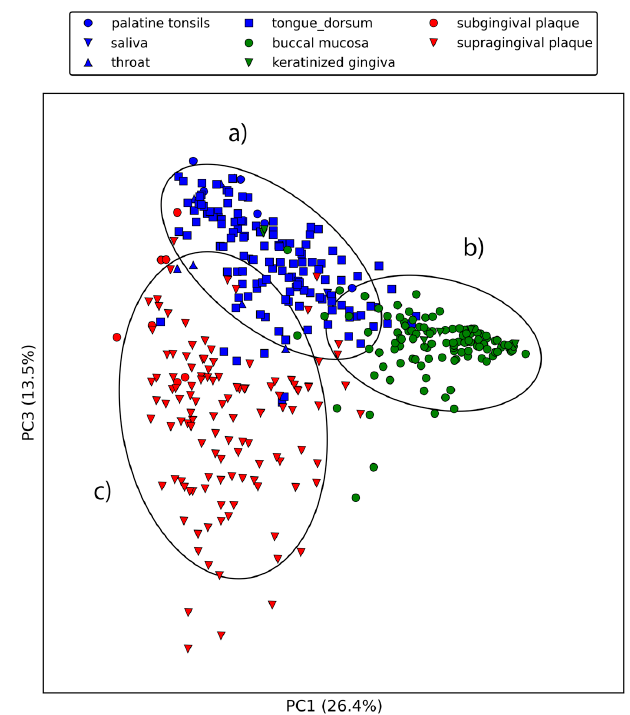
Figure 4. First and third principal components of the relative abundances of orthologous groups. ( a ) represents the oral cavity (palatine tonsils, saliva, throat, and tongue dorsum); ( b ) represents the oral vestibule (buccal mucosa and keratinized gingiva), and ( c ) represents plaque (subgingival plaque and supragingival plaque).